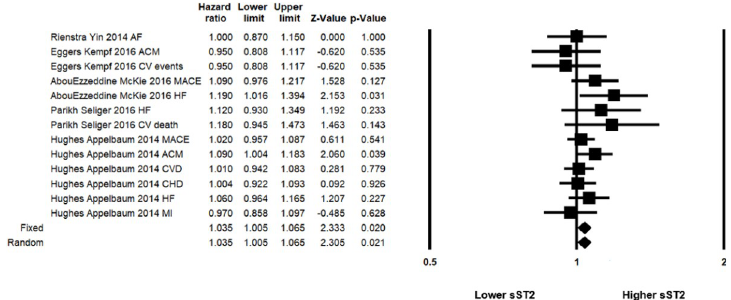
Fig 6. Summary forest plot showing the multivariate Meta-HR and 95% CI for risk of any adverse cardiovascular events in community populations and its relation to sST2 levels. The Meta-HR in the random effects model is shown by the black diamond at the bottom. The vertical line at 1 is the border for significance. AF = atrial fibrillation, ACM = all-cause mortality, CV = cardiovascular, HF = heart failure, CVD = cardiovascular disease, CHD = coronary heart disease, MI = myocardial infarction, MACE = major adverse cardiovascular